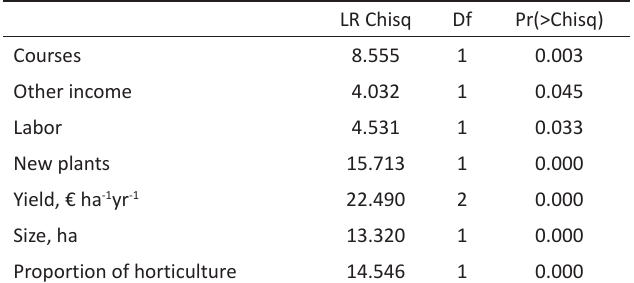
Table S1. Analysis-of-variance table for the final model resulting from stepwise selection with type-II likelihood-ratio (LR) tests of significance of each predictor given that all others are